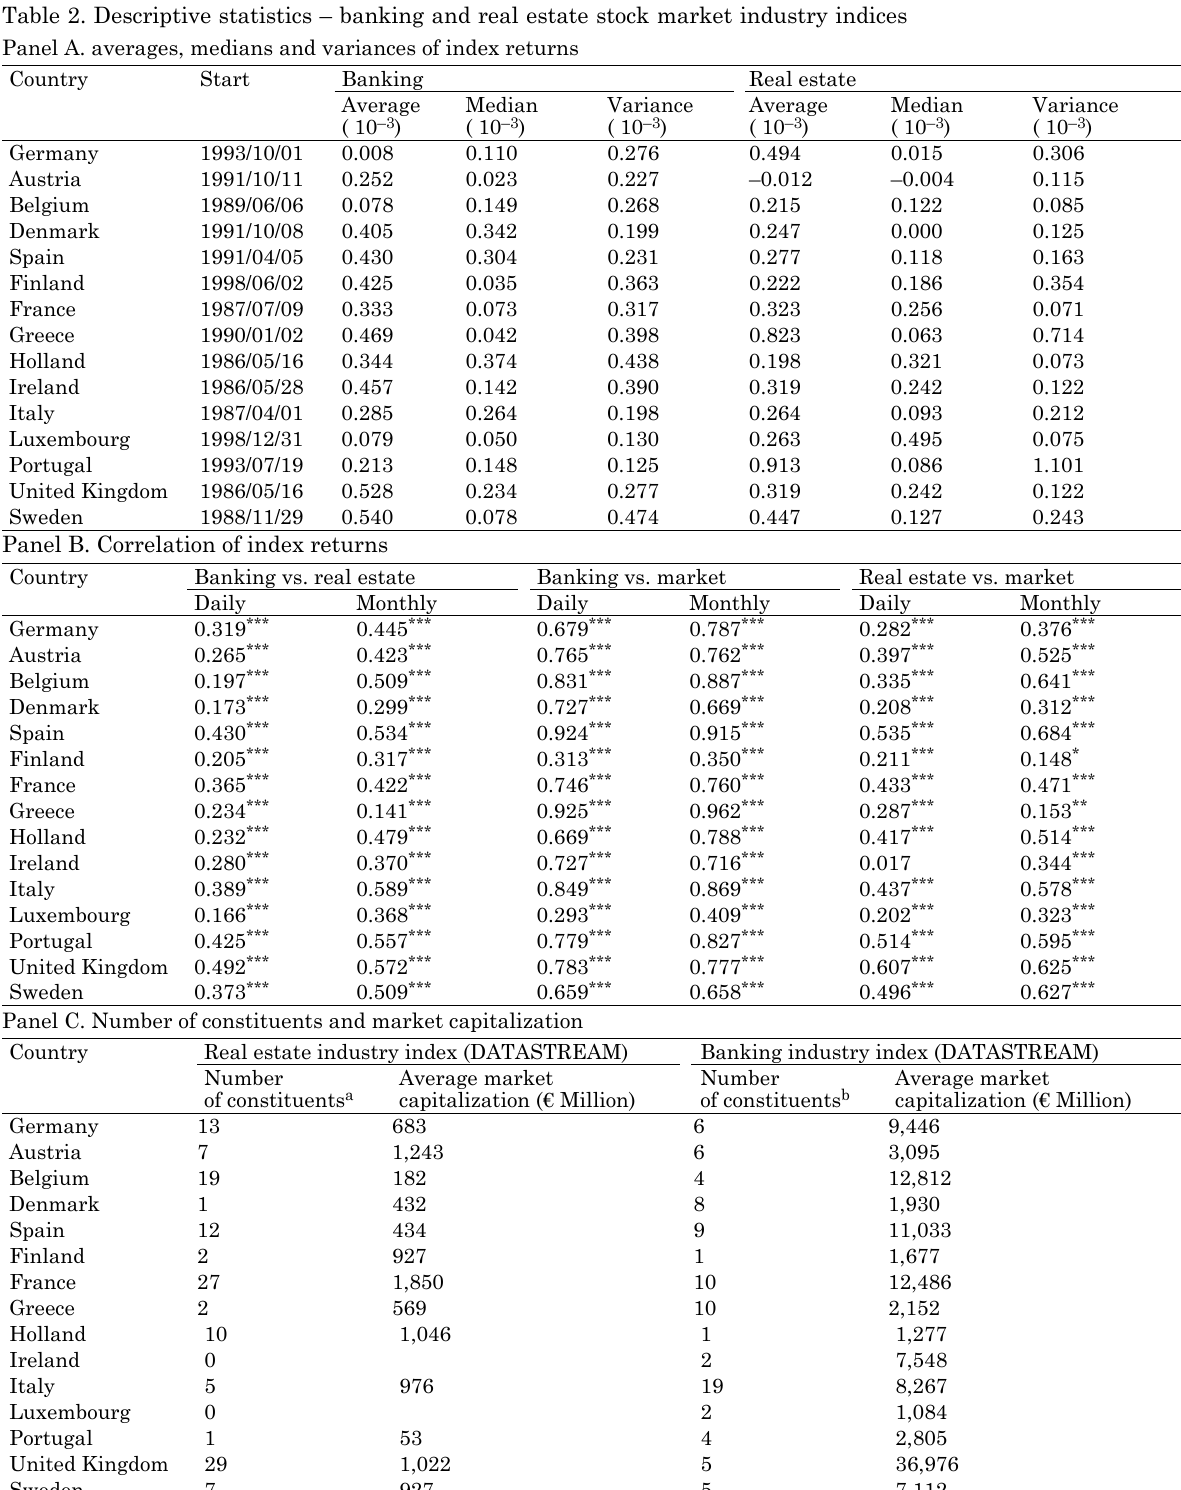
Table 2. Descriptive statistics – banking and real estate stock market industry indices Panel A. averages, medians and variances of index returns Country